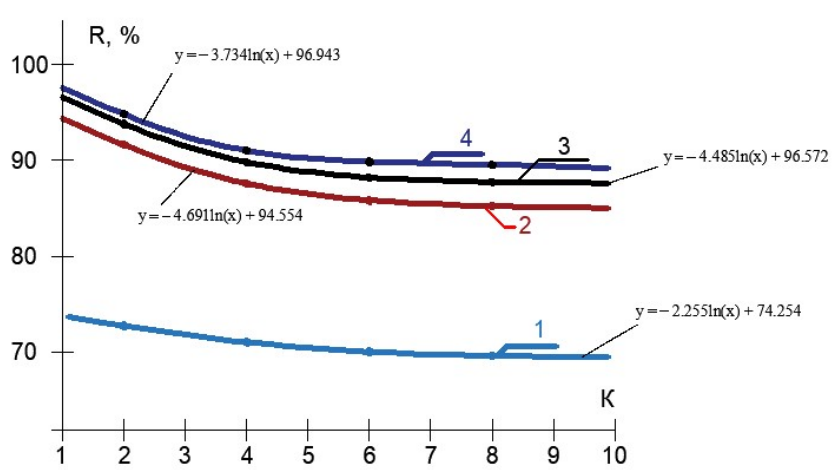
Figure 9. Results of experimental data processing: dependencies of nanofiltration membrane rejection values of different ions and impurities on K in the form of a natural logarithmic functions: 1—chlorides; 2—COD; 3—aluminum; 4—sulphates.